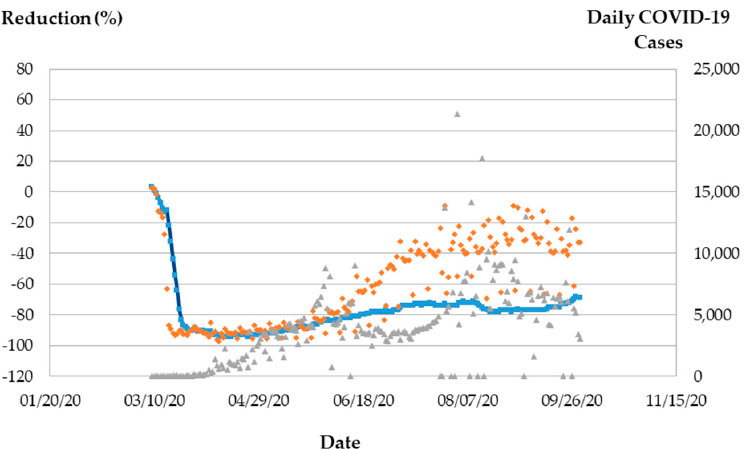
Figure 5. Percentage reduction (%) in traffic congestion (red) and urban transport use (blue), com- pared to the number of daily COVID-19 infections (gray). Santiago, Chile.